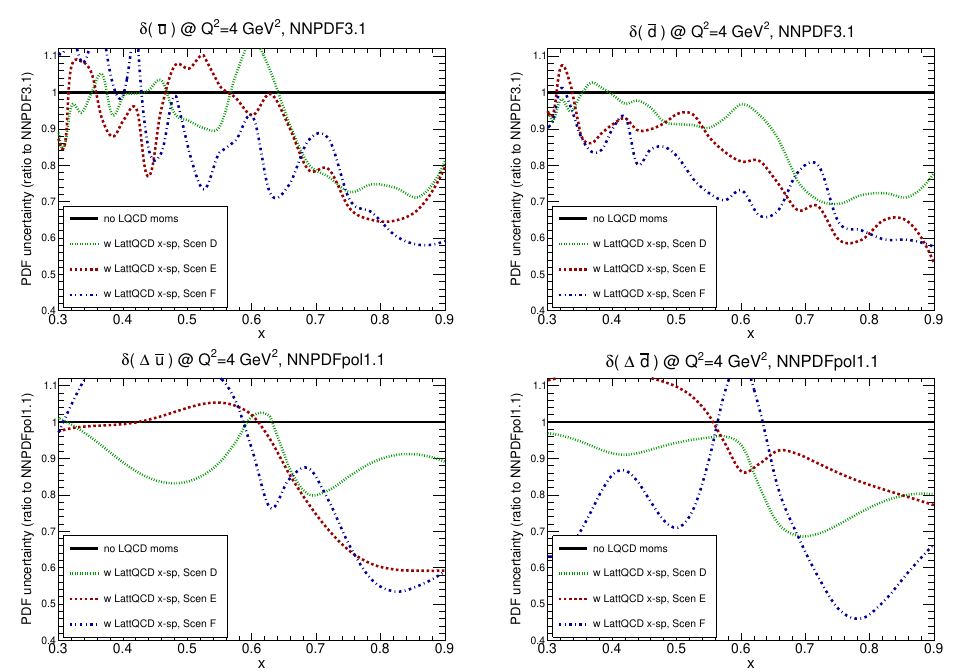
Figure 3. The ratio of PDF uncertainties to the original NNPDF3.1 (NNPDFpol1.1) in the fits where lattice- QCD pseudo-data on x -space PDFs have been added to the global unpolarized (polarized) analysis. Specifically, we show the impact on the PDF uncertainties in ¯ u and ¯ d at large- x in the upper plots, with the corresponding comparison for ∆ ¯ u and ∆ ¯ d in the lower